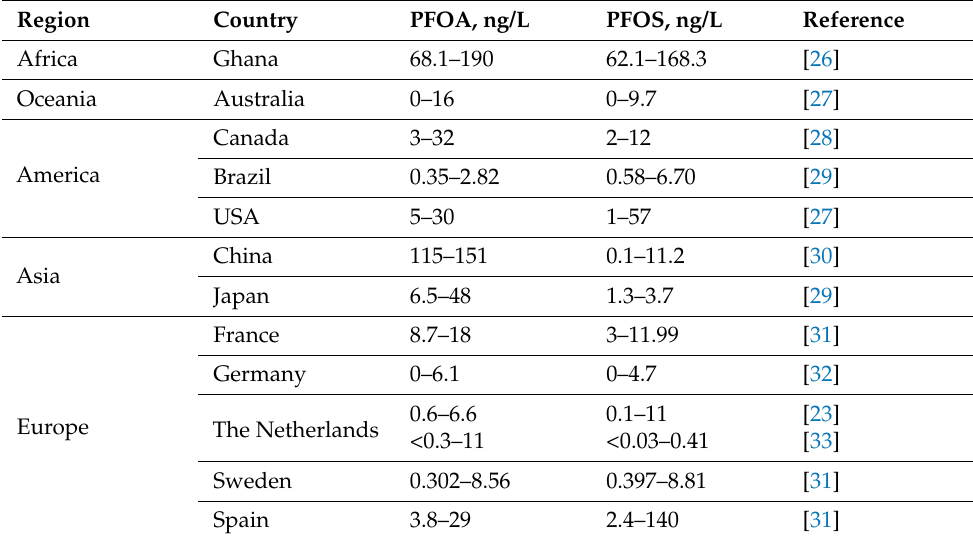
Table 1. Concentrations of PFOA and PFOS detected in tap